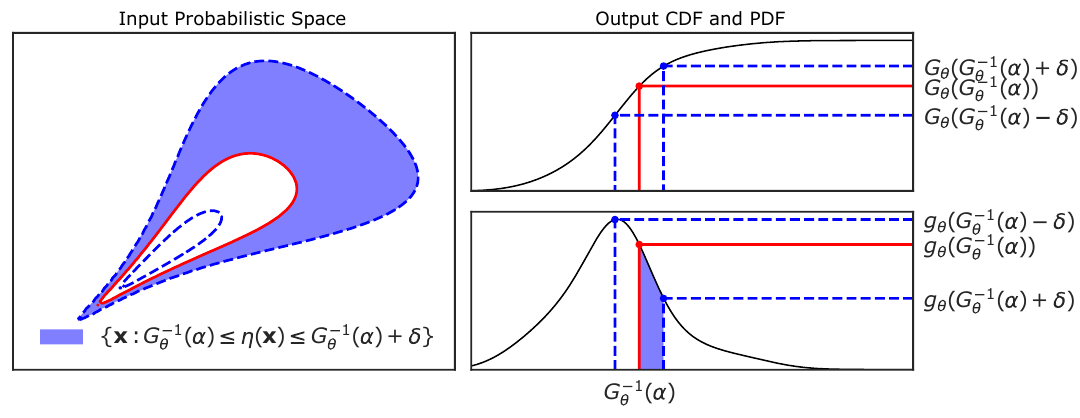
Figure 2: Pre-image (left) and image (right) of a modulus of increase of G θ at the point G −1